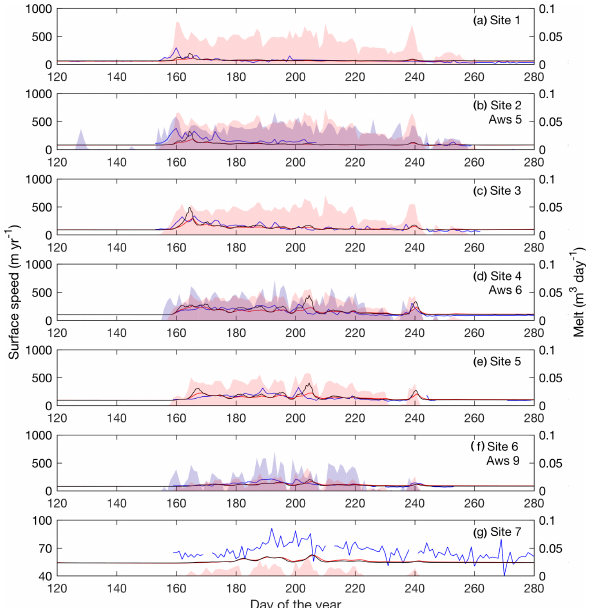
Figure 7. Modelled ice velocities plotted against GPS measure- ments for the 2011 melt season. Daily average horizontal velocity from GPS measurements are plotted in blue. Modelled velocities using the Schoof sliding law and Budd sliding law are plotted in black and red, respectively. Daily ablation from weather stations are shown in shaded blue, while RACMO2.3 surface runoff is shown in shaded red. Locations of GPS and weather station sites are shown Fig. 1. Weather station ablation rates are plotted at the nearest GPS